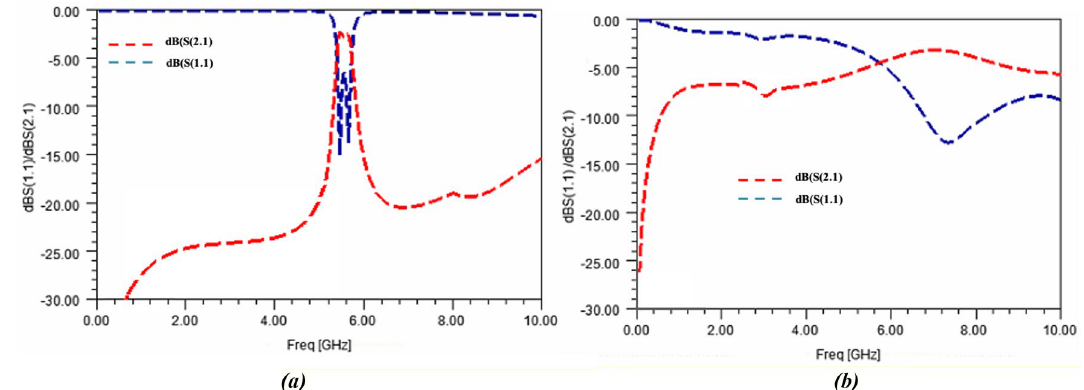
Figure 10. S-parameters obtained with full-wave simulations of the designed sensor ( a ) loaded with air and ( b ) with DI-water.